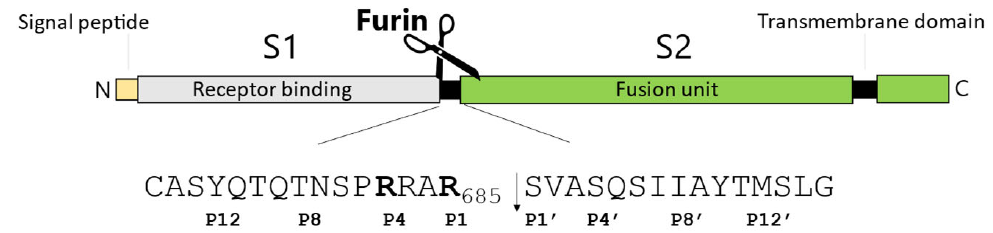
Figure 1. Schematic representation of the envelope glycoprotein S of SARS-CoV-2 and its cleavage site (sequence 671–700). Amino acids, one-letter code. Key arginines for Furin recognition are in bold. The scissile bond is designated by an arrow. Positions upstream (P12 to P1) and downstream of the cleavage (P1 ′ to P12 ′ ) are specified.